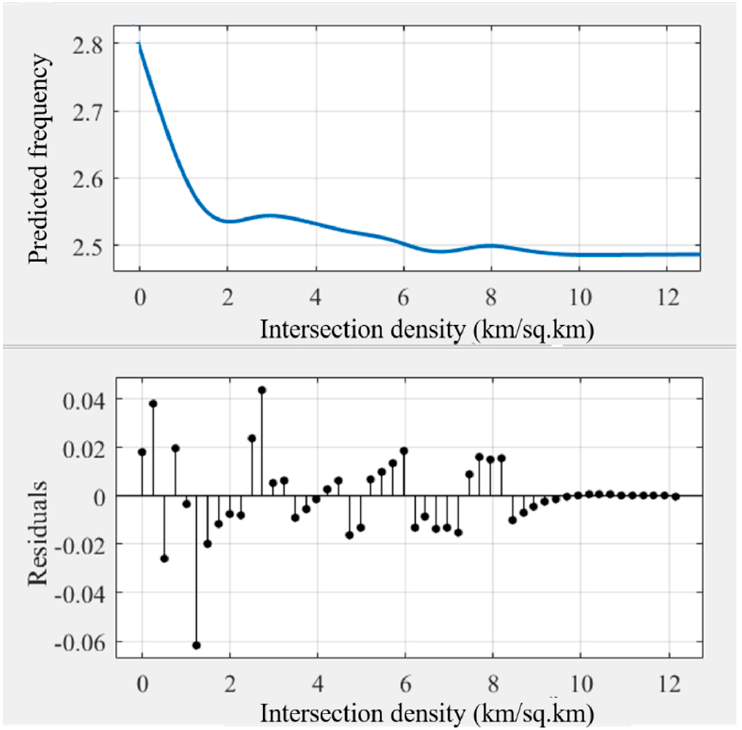
Figure 7. Nonlinear associations between intersection density (INTERDEN) and cycling frequency among older adults.